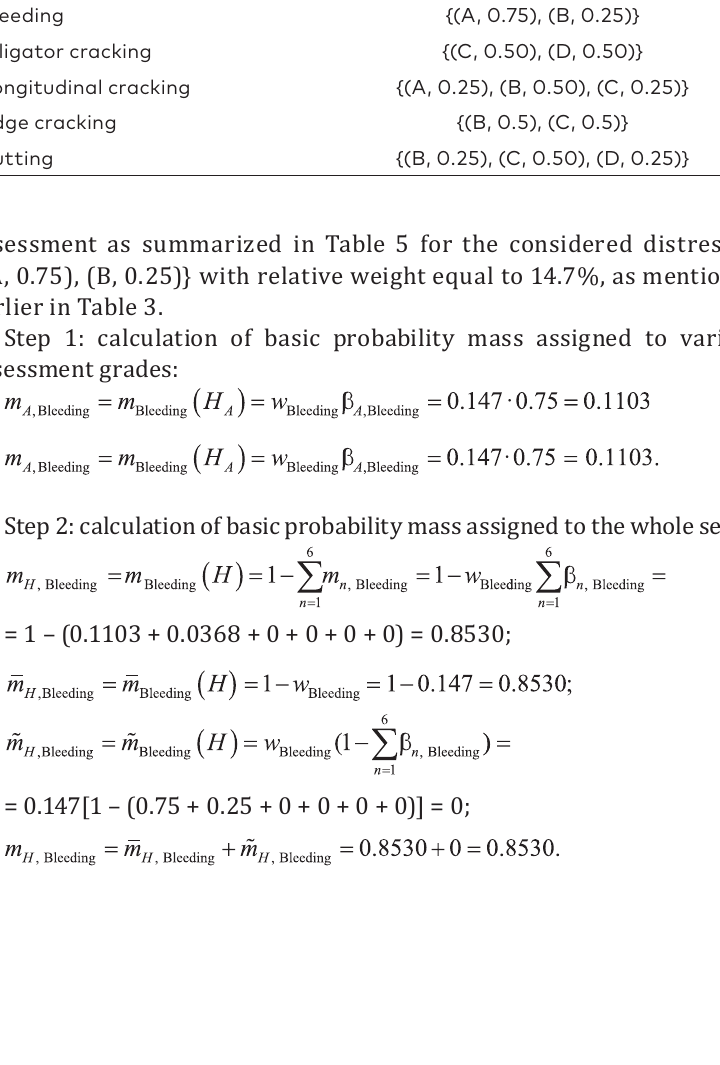
Table 6. Distributed assessment of various distresses to pavement Section 1 Pavement